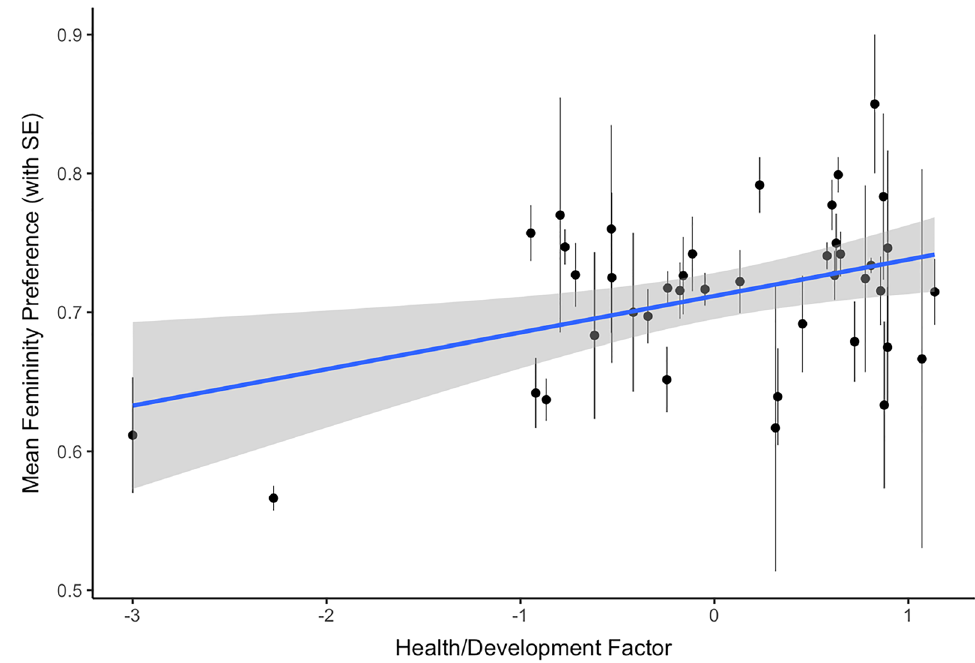
Figure 4. The significant association between scores on the health/development factor and men’s preferences for female facial femininity.